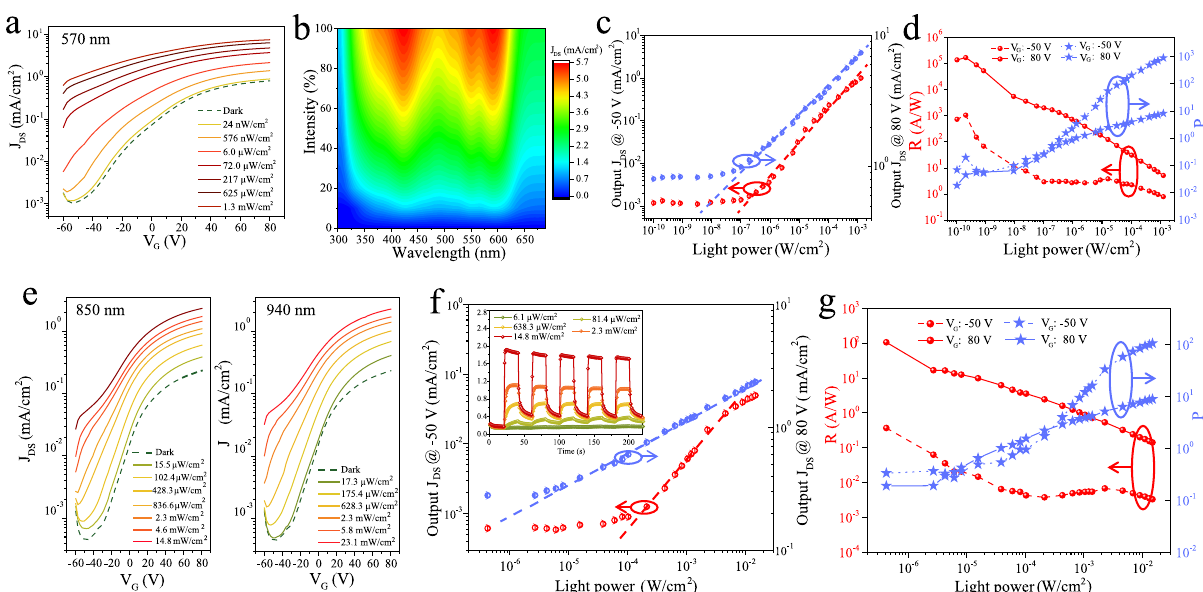
Fig. 3 Characteristics of PTCDI-C8 nanowires network vertical phototransistors (VPTs). a Transfer characteristics of phototransistors under 570 nm with various irradiances compared to that in darkness, V DS = 20 V. b , 2D map of the photocurrent density (J) recorded by scanning the irradiation wavelength and irradiance, at V G = − 50 V, V DS = 20 V. c Photocurrent density value at V G = − 50 V (red dots) and V G = 80 V (blue dots) plotted against different irradiances at 570 nm. d Photoresponsivity (R) and photosensitivity (P) versus different irradiances in the depleted area ( V DS = 20 V, V G = − 50 V, dash line) and in the accumulated area ( V DS = 20 V, V G = 80 V, solid line), the photoresponsivity and photosensitivity can reach ≈ 2 × 10 5 A/W and 1 × 10 3 at 570 nm. e , Transfer curves of PTCDI-C8 nanowires VPTs with V DS = 20 V under dark condition or different irradiances at 850 and 940 nm. f Photocurrent density value at V G = − 50 V (red dots) and V G = 80 V (blue dots) plotted against different irradiances at 850 nm. Inset: The photoswitching cycles at 850 nm working at accumulated region driven by V DS = 20 V and V G = 60 V. Y -axis demonstrates current density J (mA/cm 2 ). g R and P versus different irradiances in the depleted area ( V DS = 20 V, V G = − 50 V, dash line) and in the accumulated area ( V DS = 20 V, V G = 80 V, solid line), the photoresponsivity and photosensitivity can reach ≈ 1 × 10 2 A/W and 1.1 × 10 2 at 850